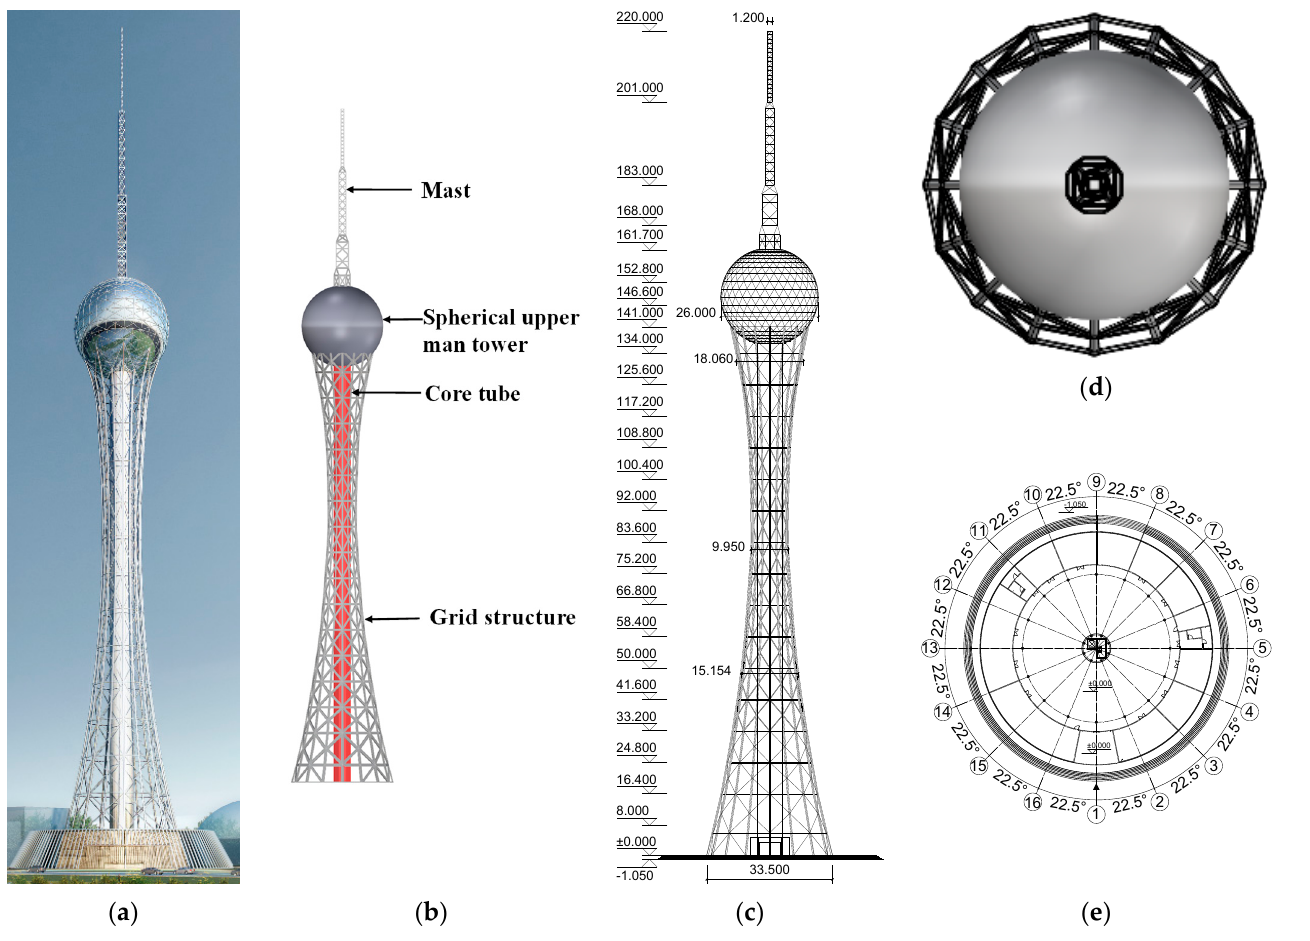
Figure 1. Architectural rendering, 3D model drawing, elevation drawing, top view, and ground floor plan of the TV tower: ( a ) Architectural rendering; ( b ) 3D model drawing; ( c ) Elevation drawing; ( d ) Top view; ( e ) Ground floor plan.